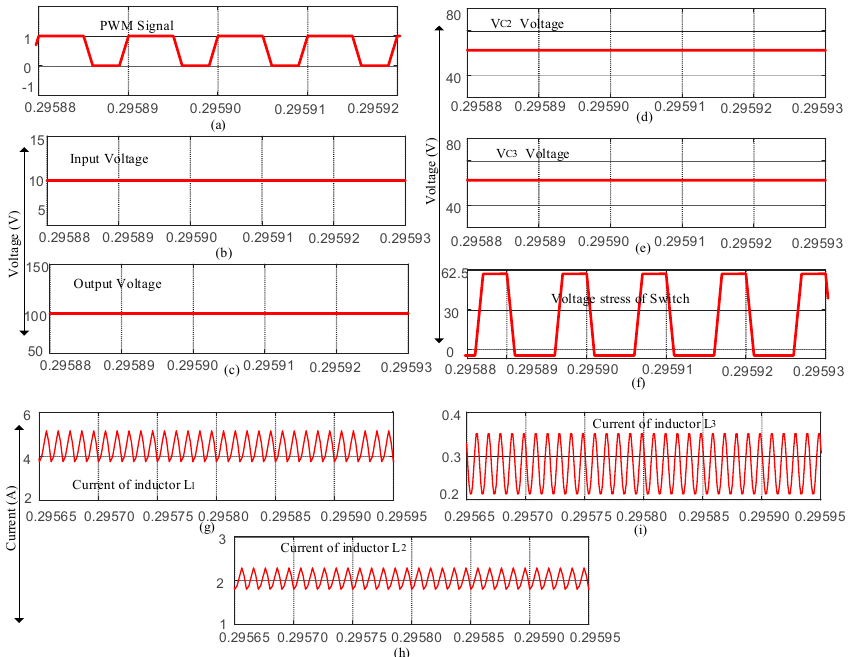
Figure 8. Simulation results of the proposed converter.